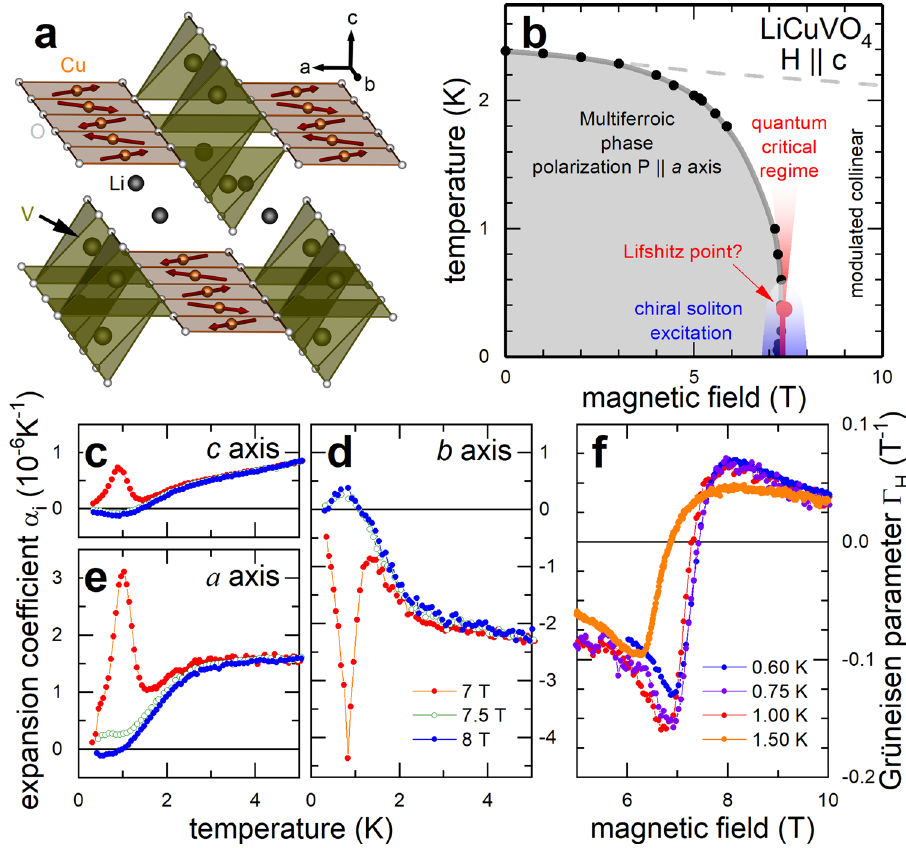
Fig. 1 Introduction of LiCuVO 4 . a A fraction of the crystal structure of LiCuVO 4 (data from ref. 23 ), the ordered magnetic moments of Cu in the multiferroic phase are indicated. b A sketch of the temperature ( T ) vs magnetic fi eld ( μ 0 H ) phase diagram. The pre-factor of H is the vacuum permeability μ = 4 π ⋅ 10 − 7 Vs(Am) − 1 . c – e The temperature-dependent thermal expansion coef fi cients α 0 external magnetic fi eld crosses the critical magnetic fi eld μ 0 H c ≃ 7.4 T, and f an analogous sign change occurs in the magnetic fi eld-dependent measurements of the magnetic Grüneisen parameter Γ H = 1/ T ∂ T / ∂ ( μ 0 H